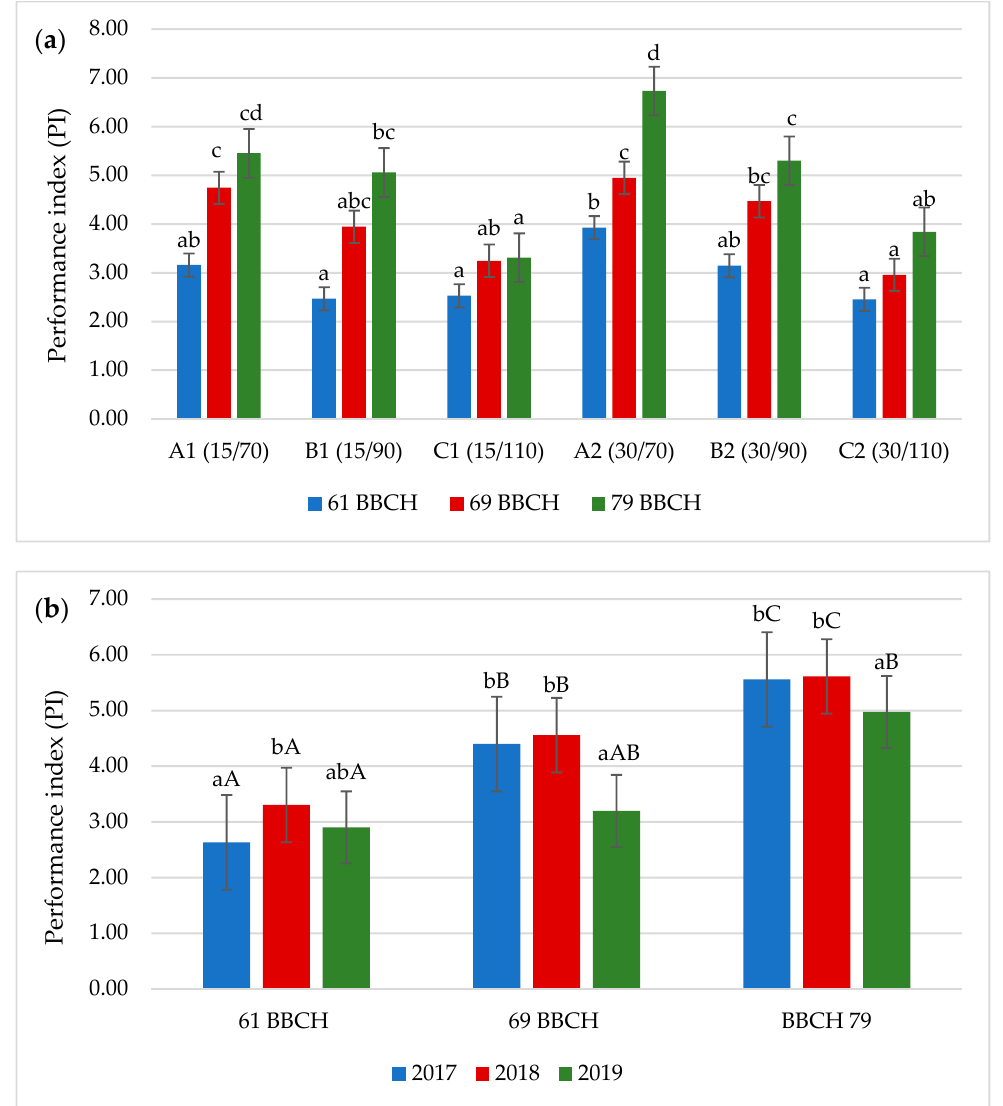
Figure 5. Effect of row spacing and sowing density on performance index (PI) in soybean leaves ( a ) between variants of the experiment during the 3-years study ( b ) between years of research. Lowercase letters indicate significant differences between the means in the measurement phases, capital letters indicate significant differences between means in the years of research according to ANOVA (followed by Tukey’s HSD test, p = 0.05).